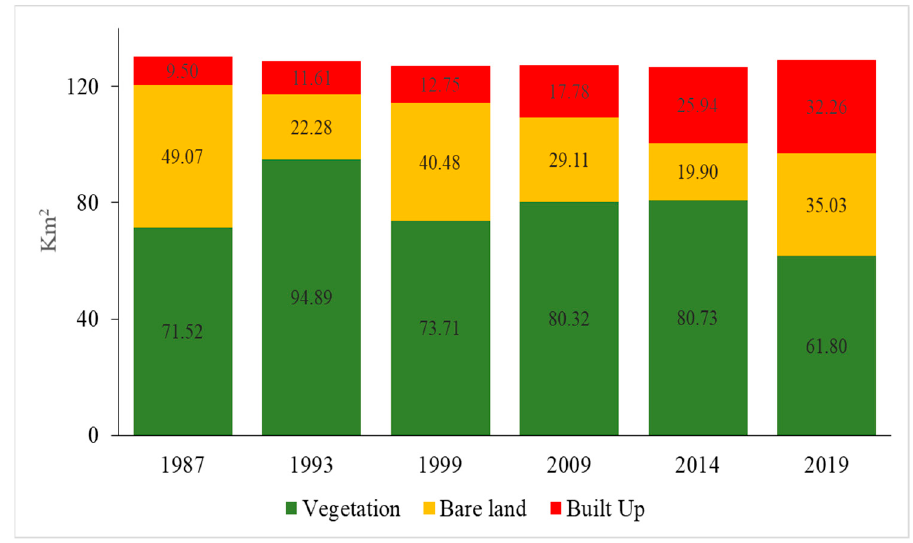
Figure 6. Areas of the three main land use/cover classes in the study area and their changes during the years 1987 to 2019 (km 2 ). the years 1987 to 2019 (km 2 ).